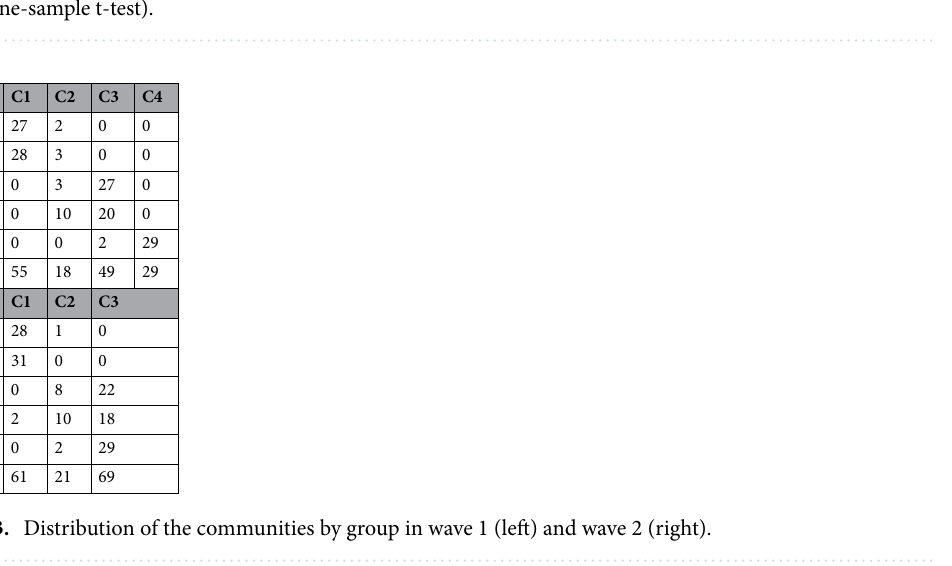
Figure 5. Boxplot of the increment in the µ parameter between December 2018 (wave 1) and May 2019 (wave 2), for each group. The difference of µ is normally distributed for all groups (Shapiro-Wilk test). Groups A, C and E show an increase in µ , whereas for the other two groups the increment is not statistically different from zero (one-sample t-test).